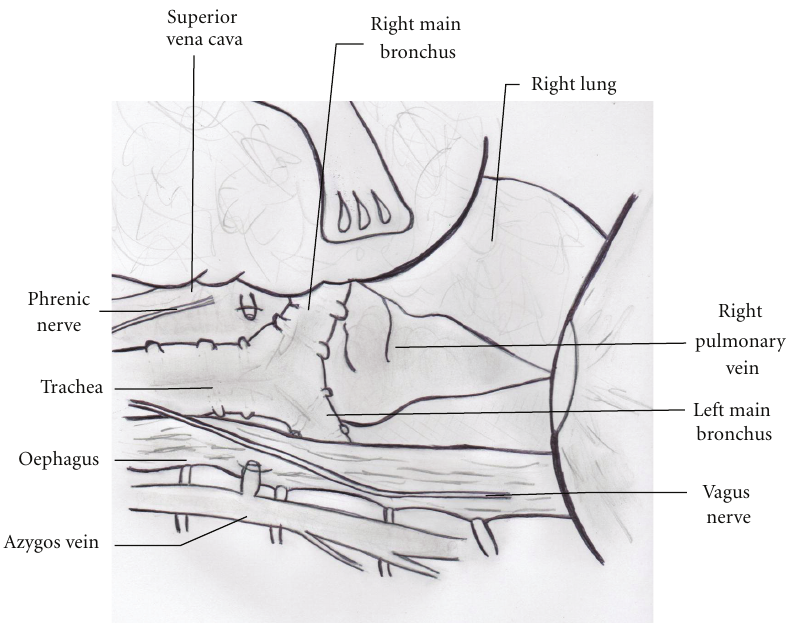
Figure 1: View of technical approach of the carina and the left main bronchus. On this view: right main bronchus, left main bronchus, trachea, right pulmonary vein, esophagus, azygos crosscut. A good way for posterior lesions of the trachea, left and right main